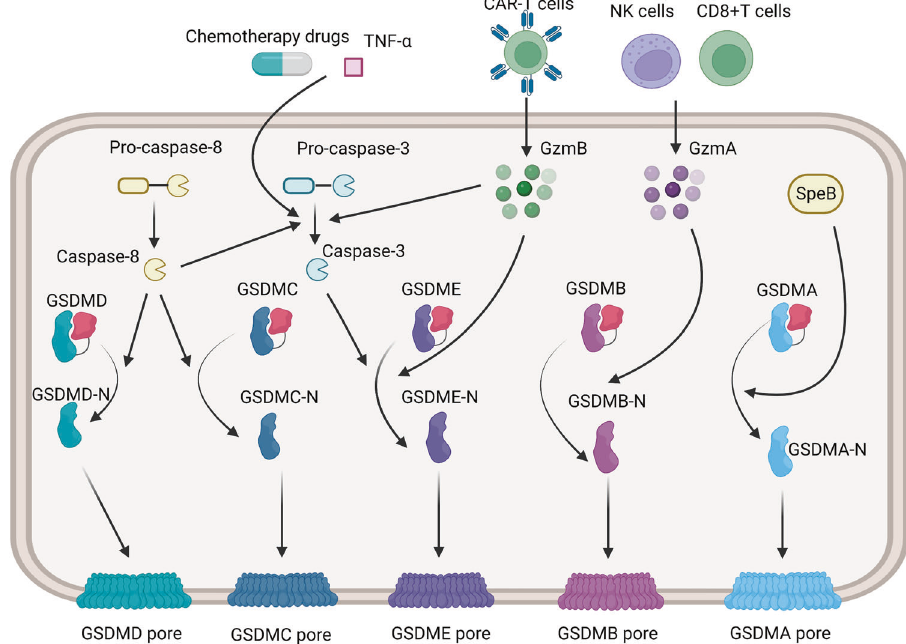
Fig. 2 Mechanisms of other pyroptosis pathways. In other pathways, GSDMs are processed by apoptotic caspases, granzymes, and other proteinases. Caspase-3 is activated by certain chemotherapeutic drugs, TNF- α , and caspase-8, then cleaves GADME and forms membrane pores. GSDMD and GSDMC are cleaved by caspase-8 directly. Granzyme B released by CAR-T cells promotes the activation of caspase-3 and cleaves GSDME directly. Granzyme A is released by NK cells and CD8 + T cells to cleave GSDMB. GSDMA is cleaved by SpeB in keratinocytes to induce pyroptosis.